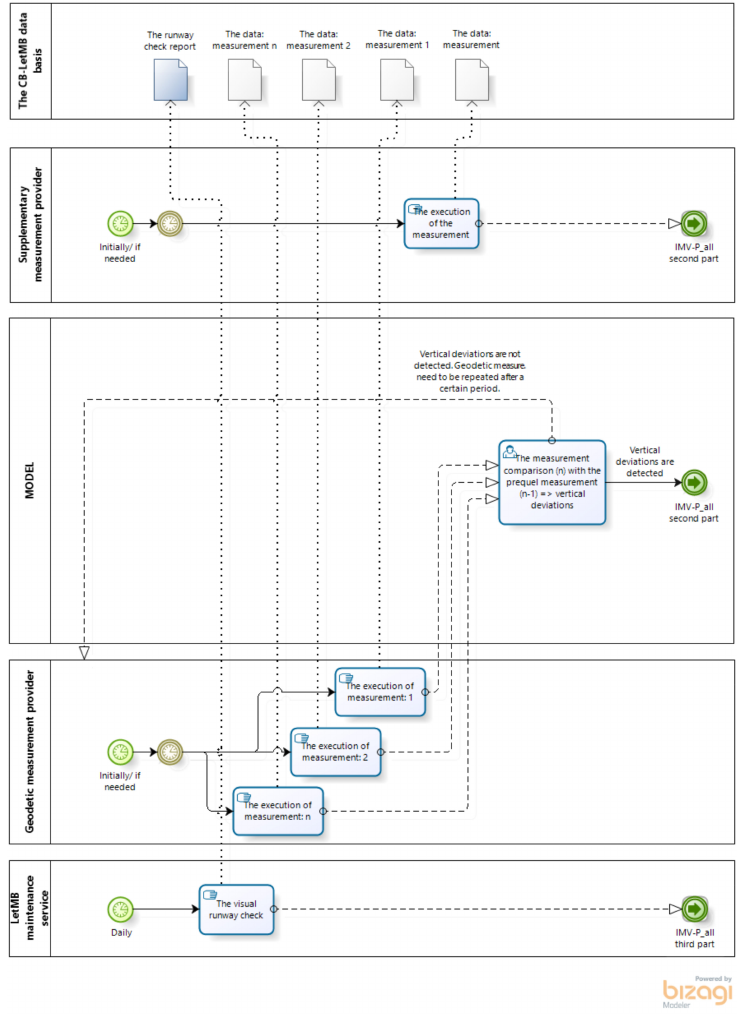
Figure 3. The monitoring process model, sub-process IMV-P_all, part